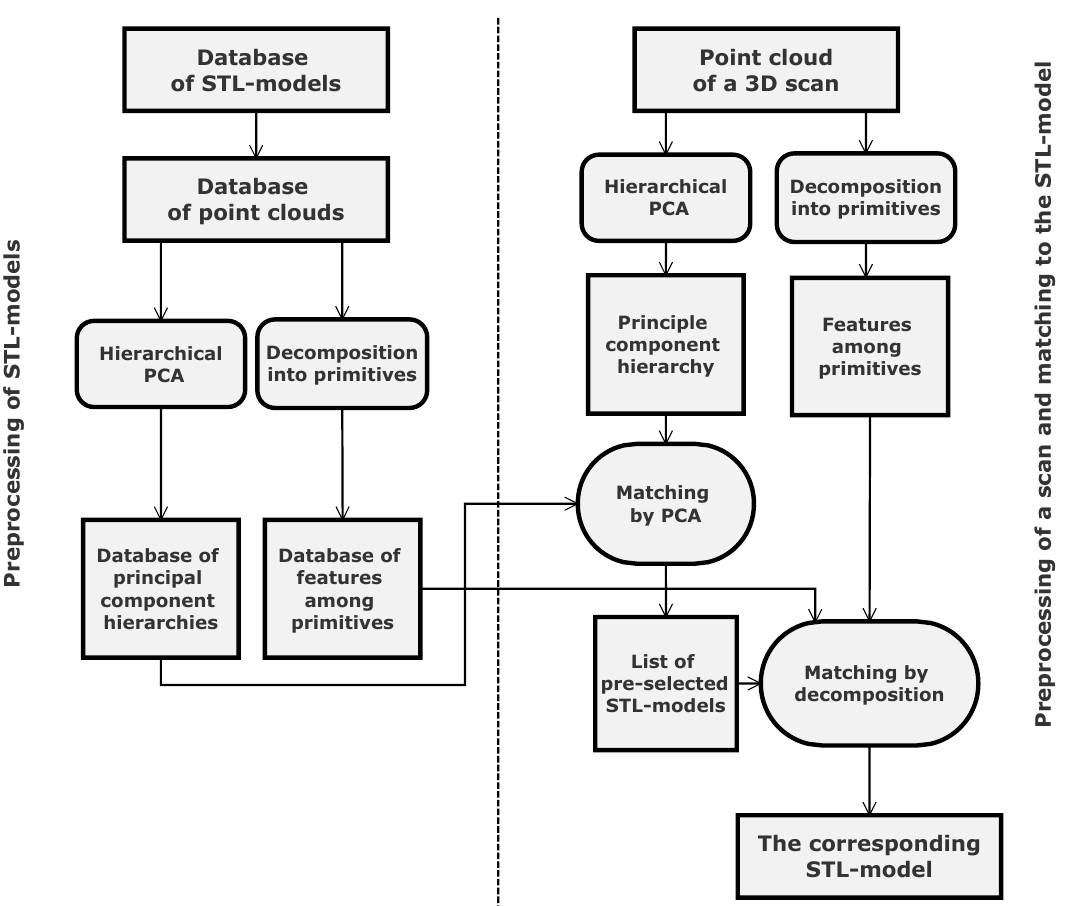
Figure 1. The overall scheme of the proposed